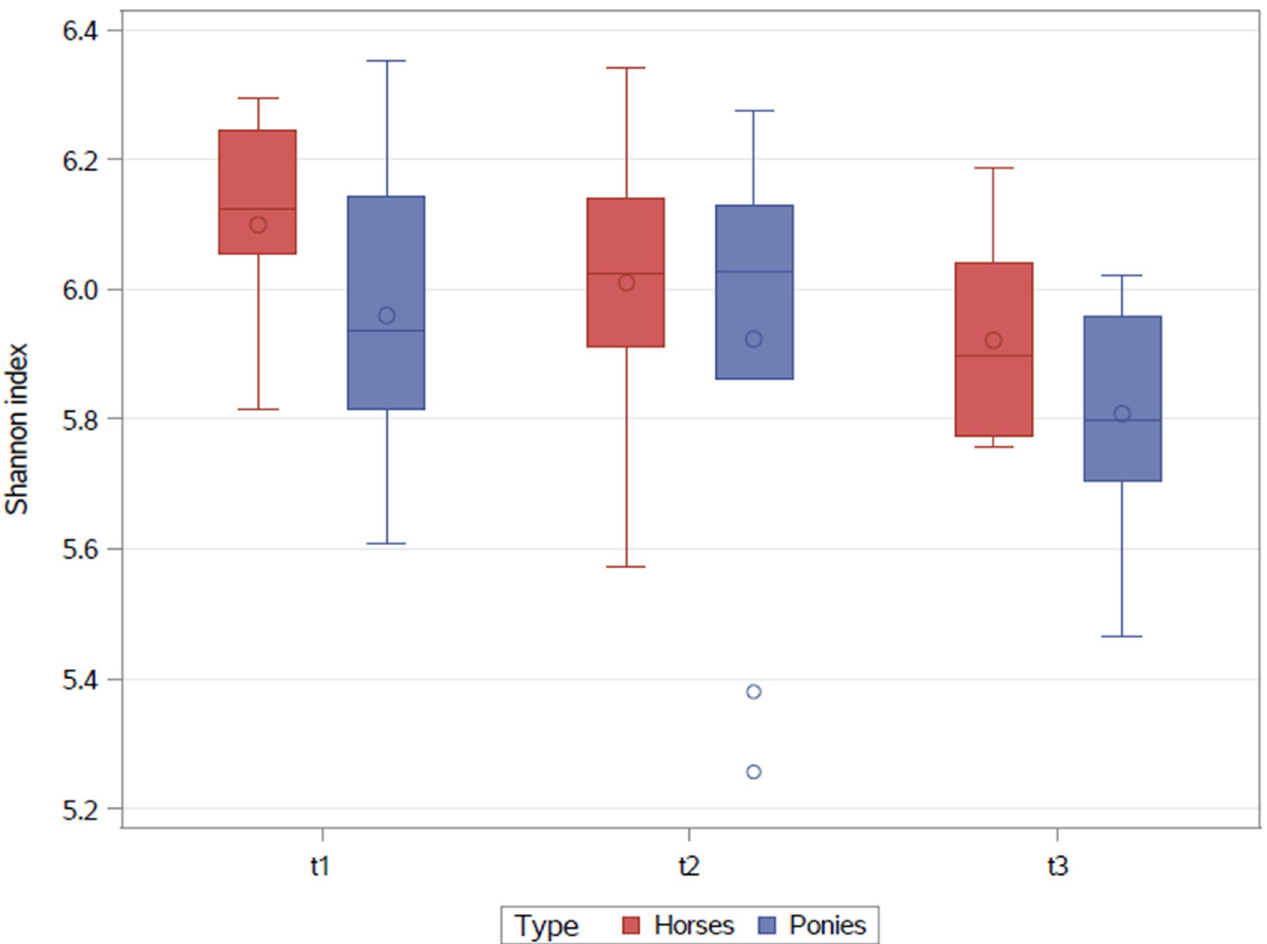
Fig 1. Shannon index at the three sampling points (t1-t3) for horses and ponies. The interquartile range is indicated by the box. The dot inside the box indicates the mean and the line the median. The whiskers represent the lower and upper extremes. Outliers are indicated as single